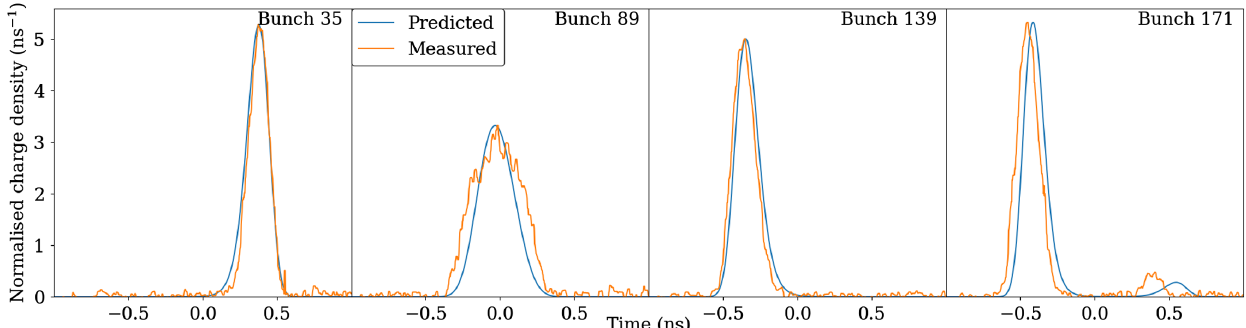
FIG. 4. Four different bunch profiles as measured using the synchrotron light in comparison with profiles predicted by the theory taking the measured bunch train as an